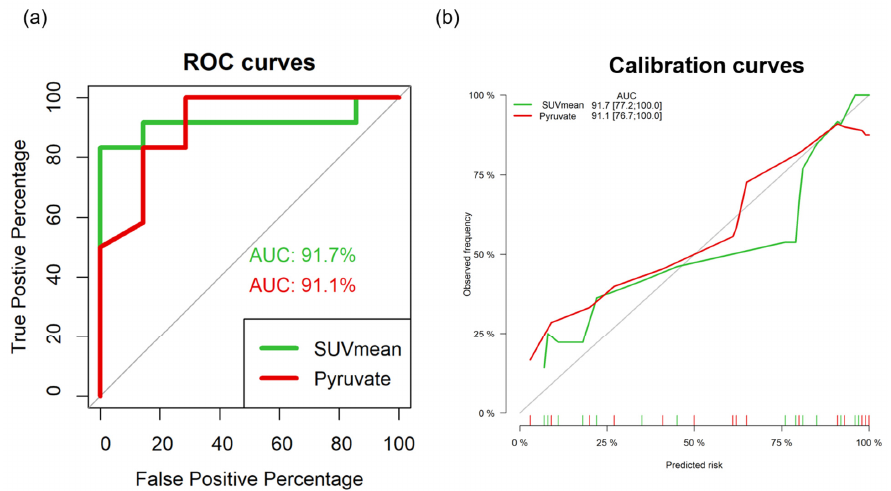
Figure 7. ROC curves and calibration curves of PET/CT parameters, SUV mean , and serum metabo- lites, pyruvate to diagnose the localized (N = 7) or metastatic (N = 12) diseases. ( a ) The imaging parameter, SUV mean shows slightly higher AUC values than that of serum metabolite, pyruvate; however, the AUCs of the two parameters are over 90%, SUV mean and pyruvate are the promising predictors for the differentiation of localized or metastatic lung cancers. ( b ) The calibration curve of imaging parameter and serum metabolite, normalized pyruvate level in a preclinical lung cancer